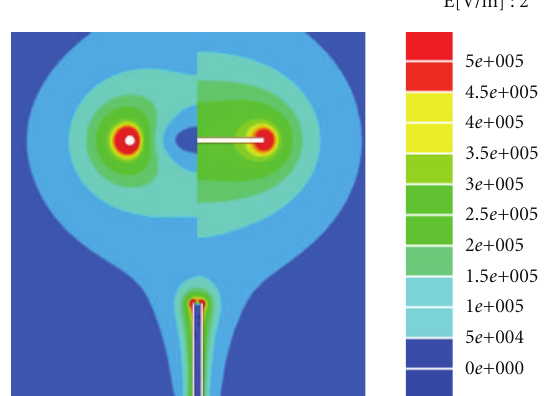
Figure 9: Comparison of plate and ring.